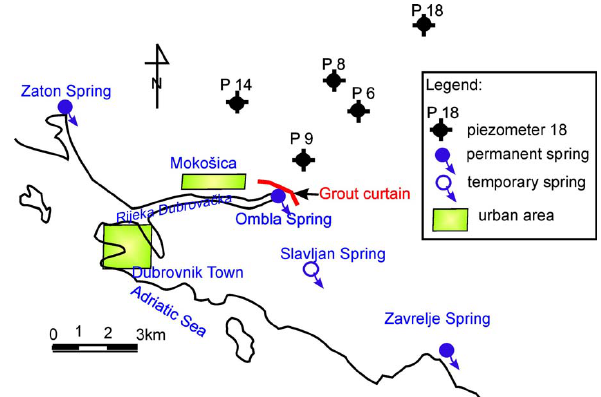
Fig. 3. Location map indicating the position of the projected grout curtain, five piezometers (P6, P8, P9, P14 and P18), the data of which are used in this article, and the adjacent karst springs (Za- ton, Ombla, Slavljan and